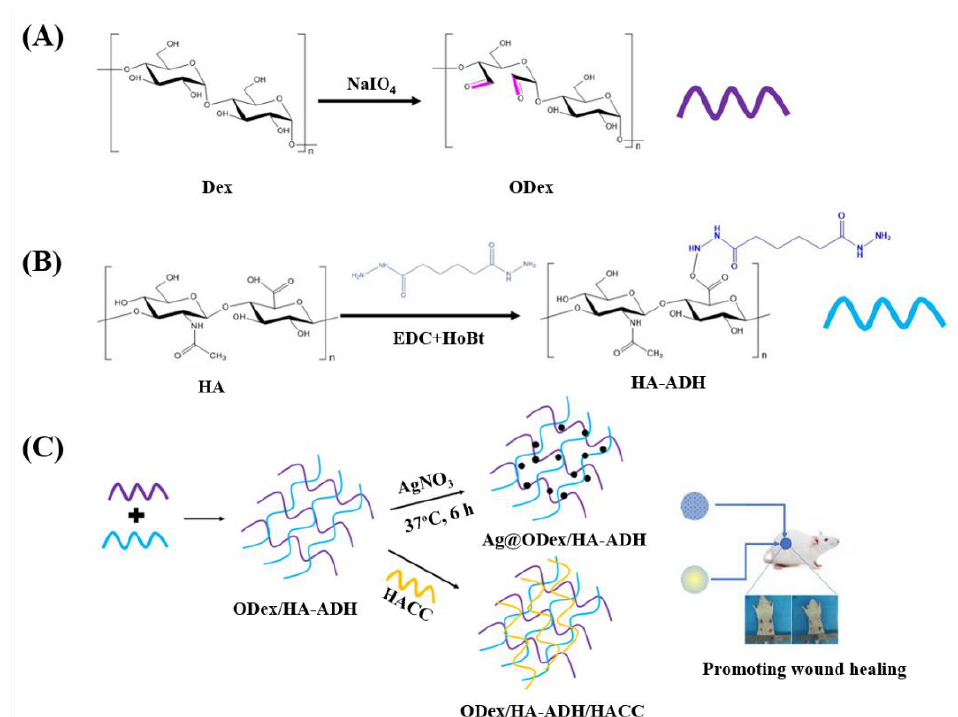
Scheme 1. Schematic illustration of synthesis and application of hydrogel. ( A ) Preparation scheme of HA-ADH; ( B ) Preparation scheme of ODex; ( C ) Preparation and application of hydrogels in a rat burn infection model.